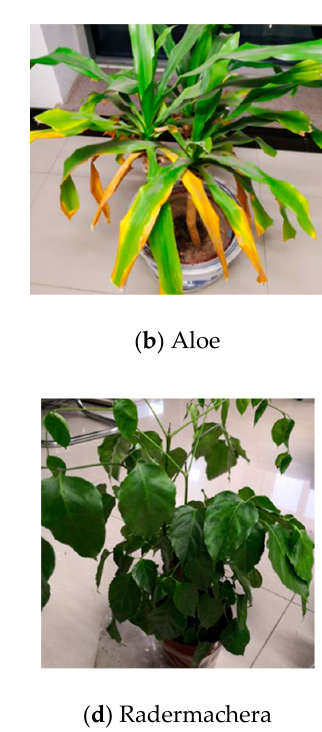
Figure 6. Four di ff erent plants employed in lab experiment. ( a ) Dracaena, ( b ) Aloe, ( c ) Rubber plant, Figure 6. Four different plants employed in lab experiment.( a ) Dracaena, ( b ) Aloe, ( c ) Rubber plant, ( d ) ( d ) Radermachera